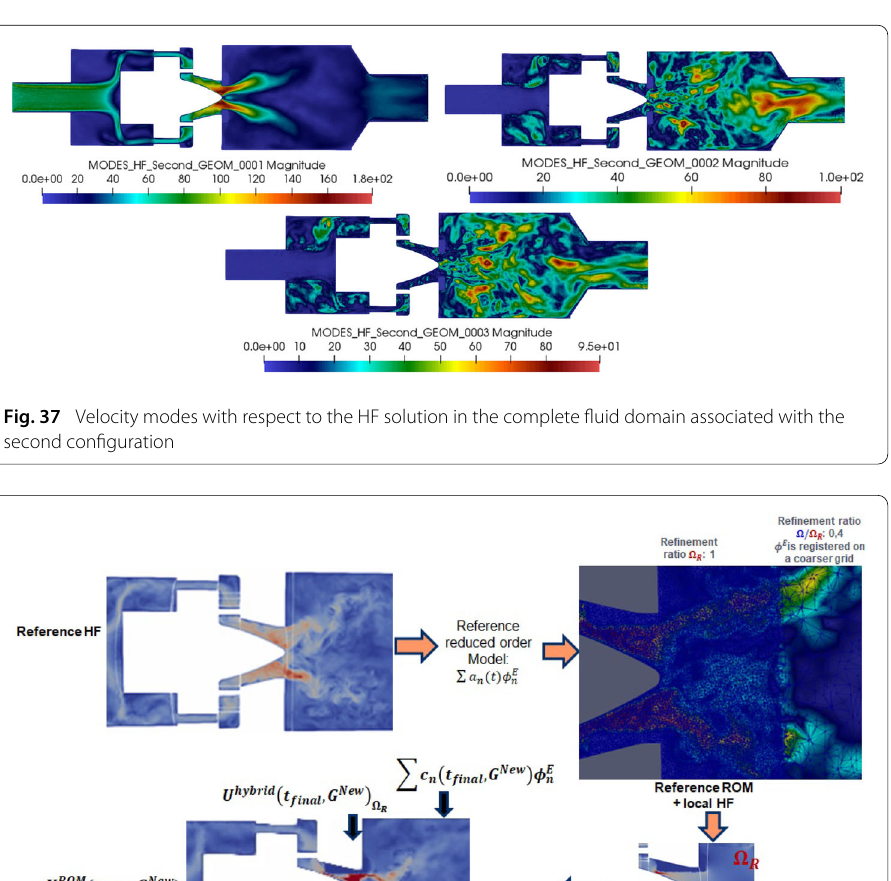
Specification for the design in combustion: a posteriori verification of the ROM quality on a 1D quantity of